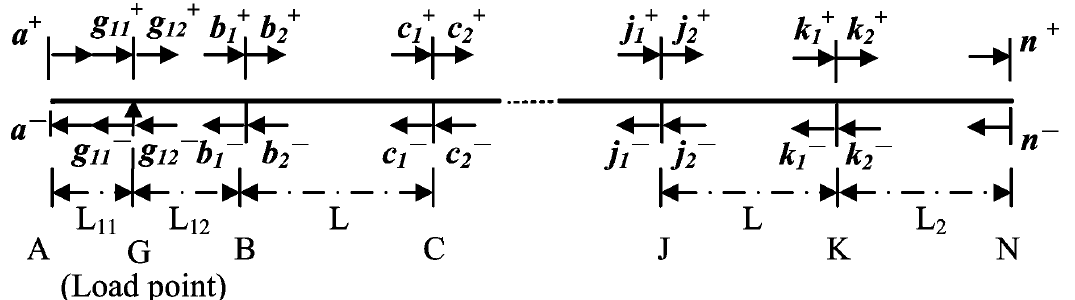
Figure 5. Wave analysis of a finite locally resonant (LR) beam.